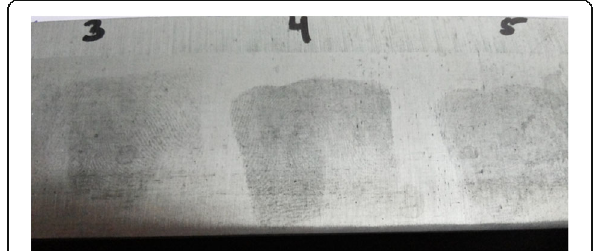
Fig. 2 Developed latent fingerprints using black powder on knife blade after submersion in fresh water for 2 days. (Score